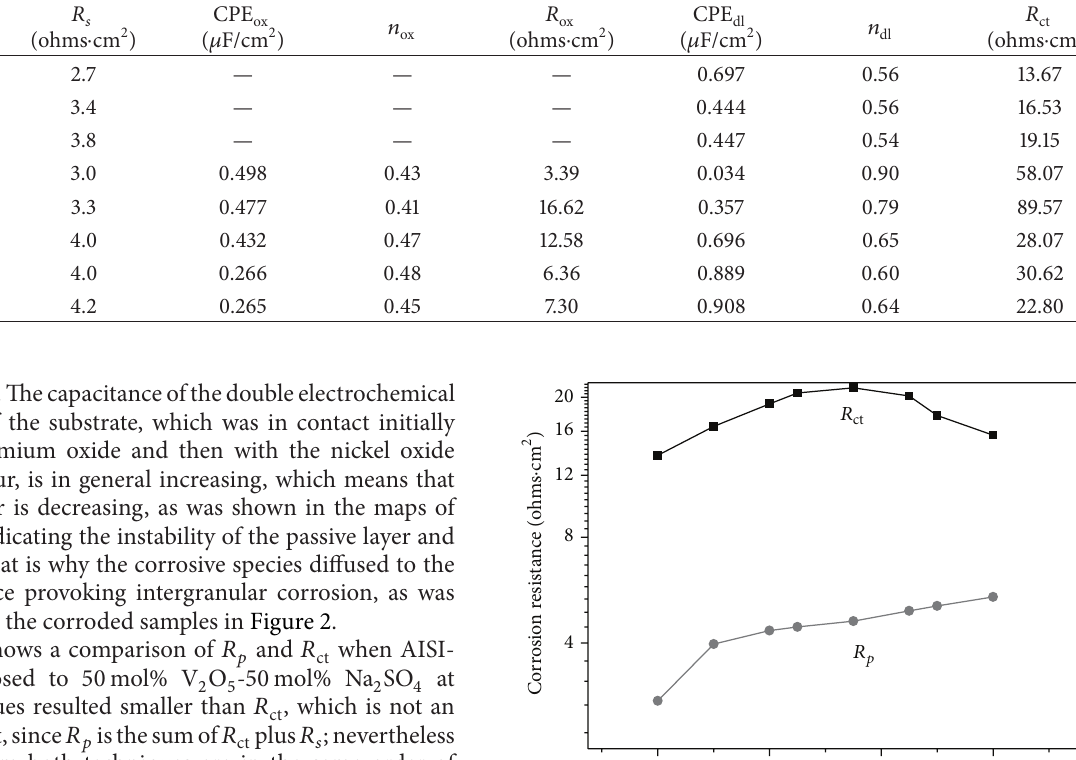
Table 3: Calculated parameters obtained from the simulation of EIS experimental data for AISI-309 exposed in molten salts 50 mol% V SO at 700 ∘ C. 50 mol% Na 2 4